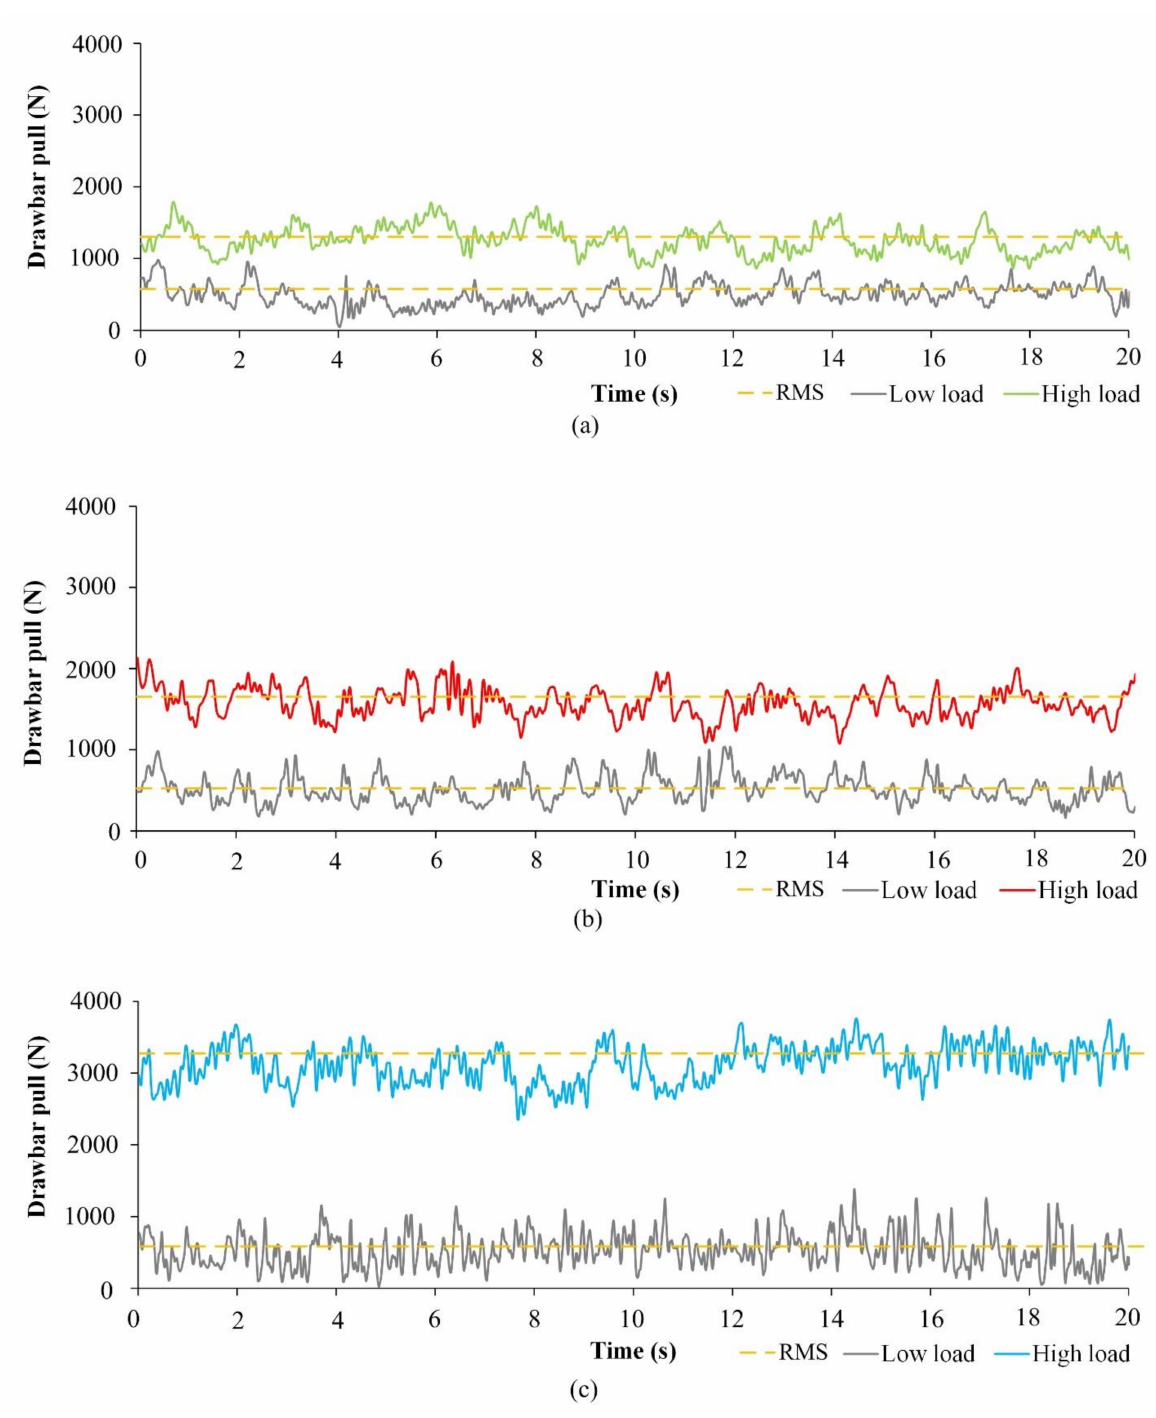
Figure 6. The drawbar pulls of the test tractor with low and high loads: ( a ) standard tires; ( b ) spike tires; ( c ) blade